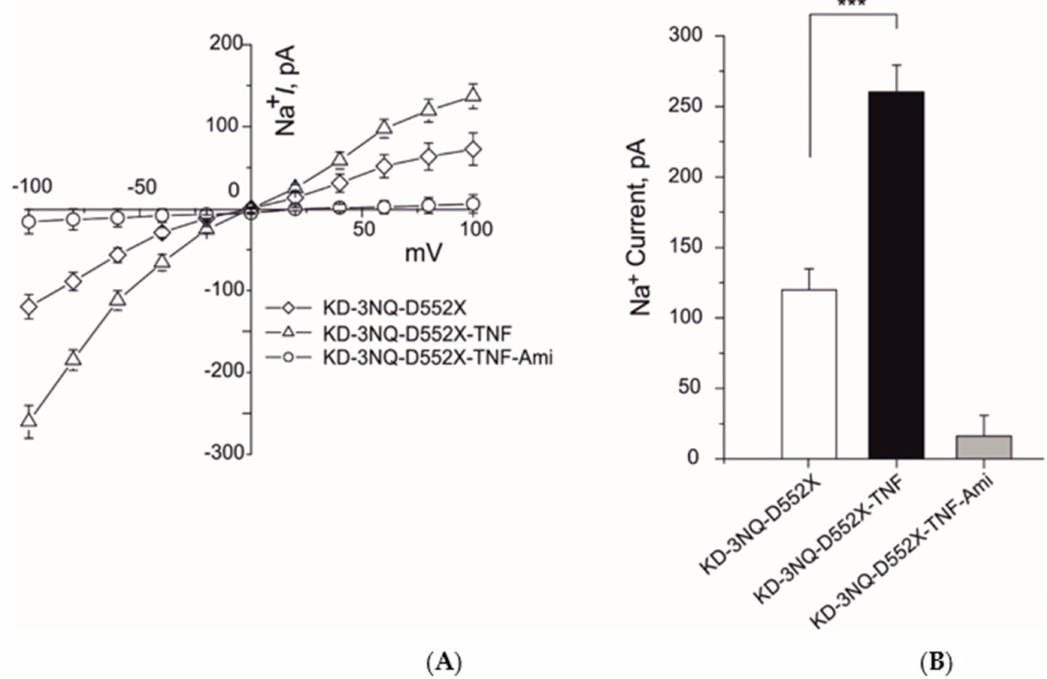
Figure 5. Overexpression of N-linked glycosylation sites mutated and carboxyl terminal dele δ -ENaC (3NQ-D522X) restored the TNF mediated activation of ENaC in δ -ENaC KD A549 cells. ( A ) IV plots of whole-cell (10 µ M) amiloride-sensitive ENaC currents of indicated experimental settings are shown. ( B ) Mean values of whole-cell inward sodium currents at − 100 mV of indicated experimental settings are shown. Significant differences are indicated, *** p < 0.001, unpaired Student’s t -test, n =